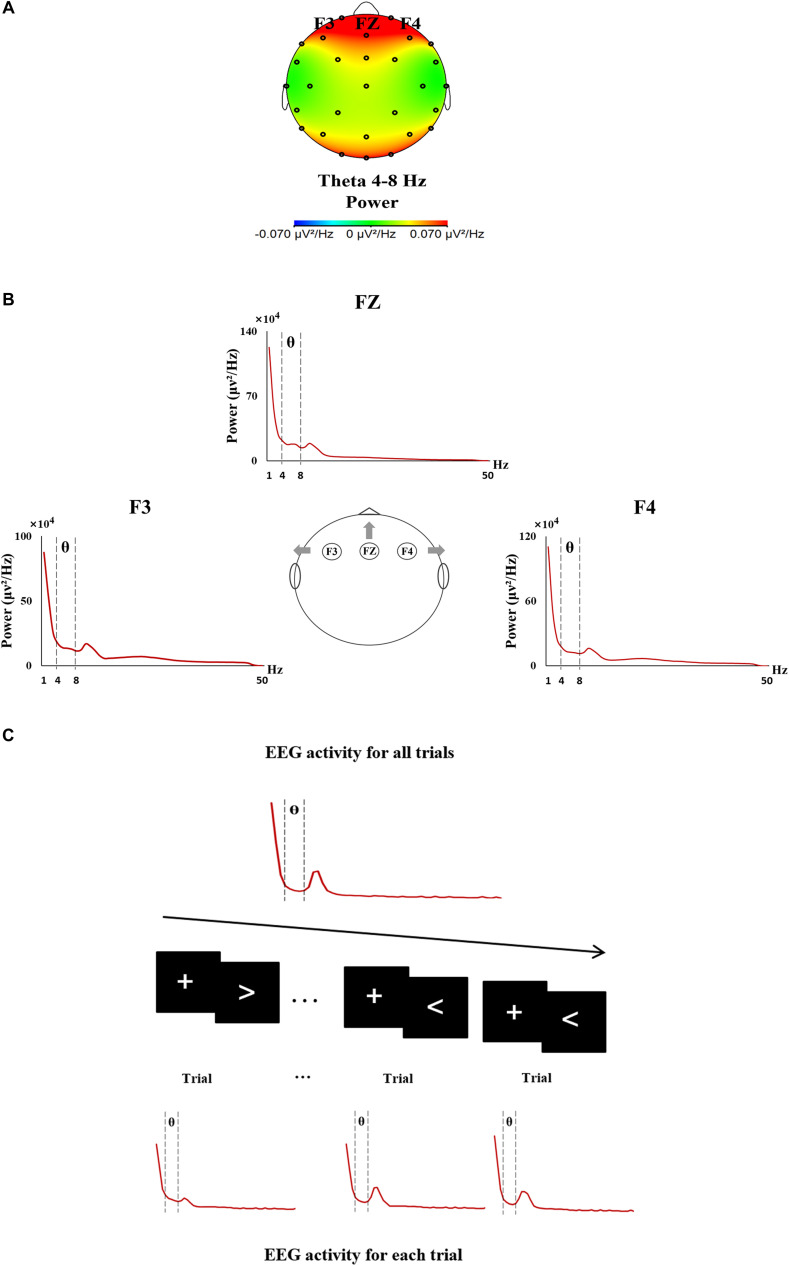
The procedure of EEG data analyses. (A) EEG topographic map showing the theta activity mainly located in the frontal area during the sustained attention task. (B) Frontal theta EEG activity was analyzed from 4 to 8 Hz at F3, FZ, and F4. (C) The procedure of the trial-by-trial analysis of EEG activity.